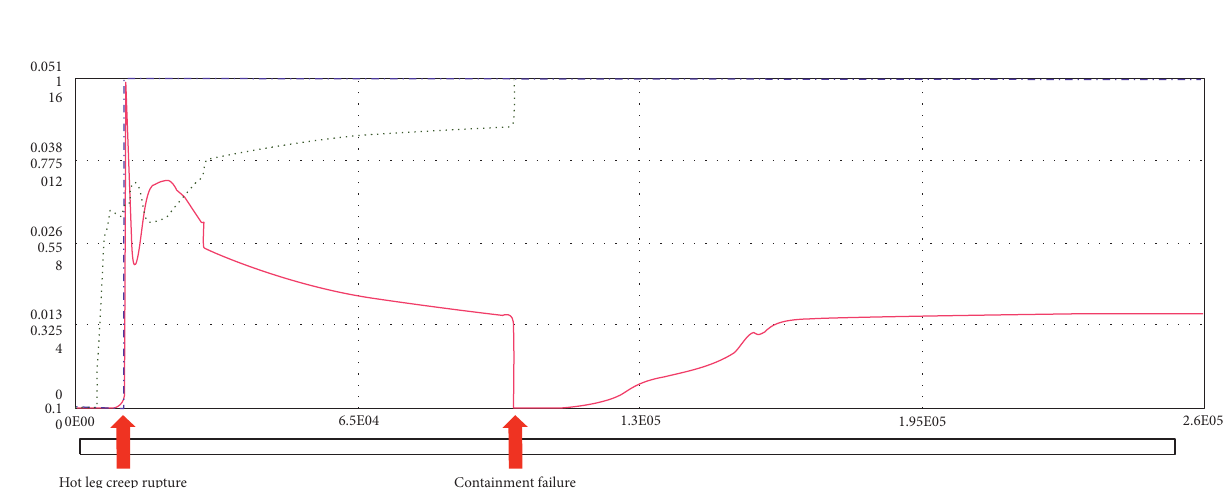
Figure 18: Steam mole fraction (dotted green), hydrogen mole fraction (solid red), and external injection mass flow rate for compartment ①